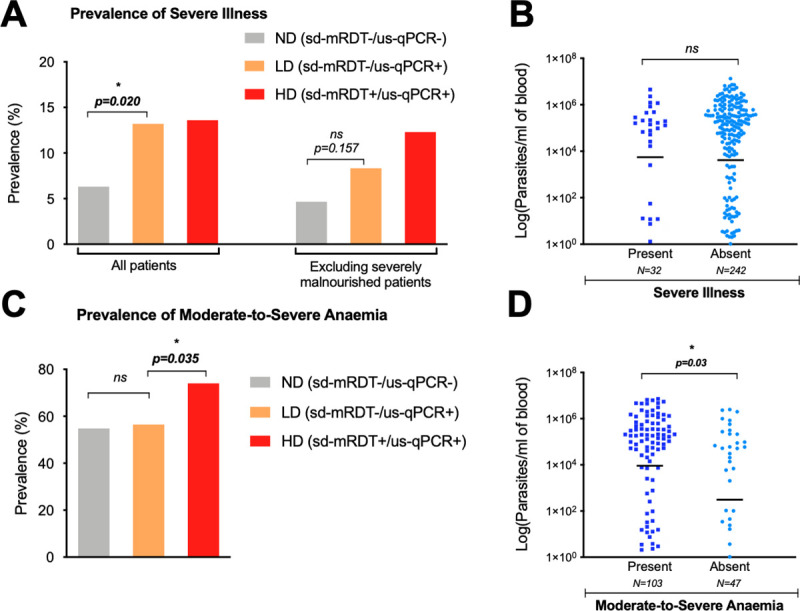
Distribution of severe illness and anemia between patients with LD, HD, or ND parasitemia.(A) Prevalence of severe illness amongst all patients (left) versus a subgroup excluding severely malnourished patients (right). (B) Log parasite densities in Pf-positive cases (qPCR-detectable: LD and HD), in the presence or absence of severe illness. (C) Prevalence of patients with moderate-to-severe anemia. (D) Log parasite densities in Pf-positive cases (qPCR-detectable: LD and HD), in the presence or absence of moderate-to-severe anemia. Severe malnutrition is defined as weight-for-age Z-score < −3 and/or MUAC <5–11 cm. Moderate-to-severe anemia is defined as memoglobin <9 g/dl. *p < 0.05. HD, high-density Pf infection, LD, low-density Pf infection; RDT, rapid diagnostic test; MUAC, mid-upper arm circumference; ND, no detectable Pf parasitemia; ns, nonsignificant; sd-mRDT, standard malaria RDT; us-qPCR, ultrasensitive quantitative polymerase chain reaction.